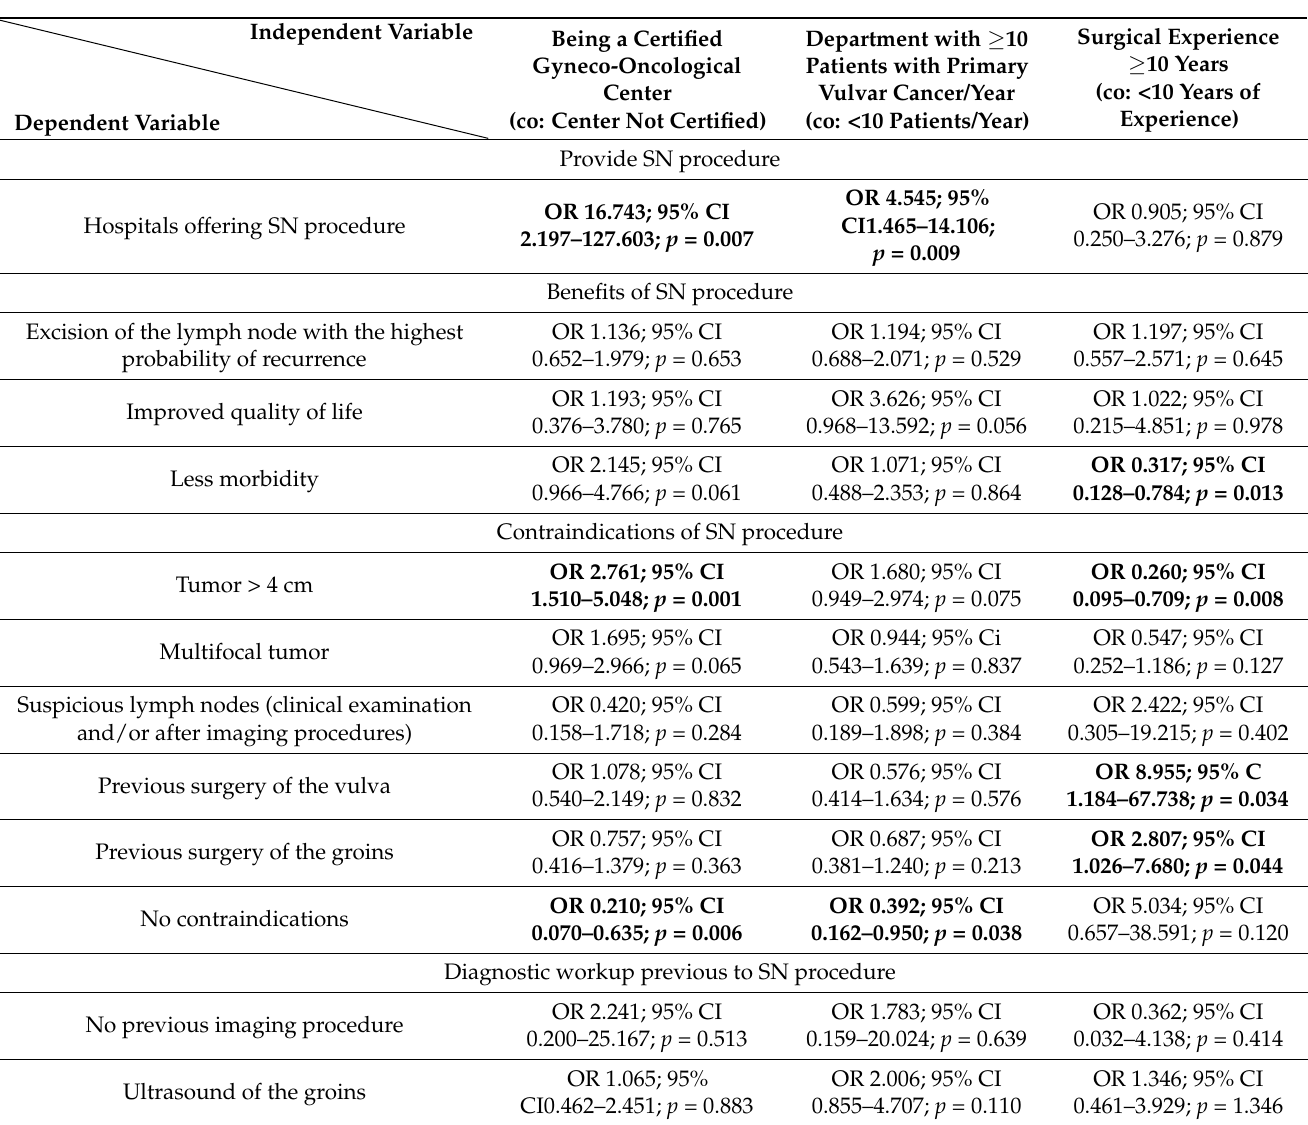
Table 3. Demographic characteristics in the perspective of adherence to current national and interna- tional